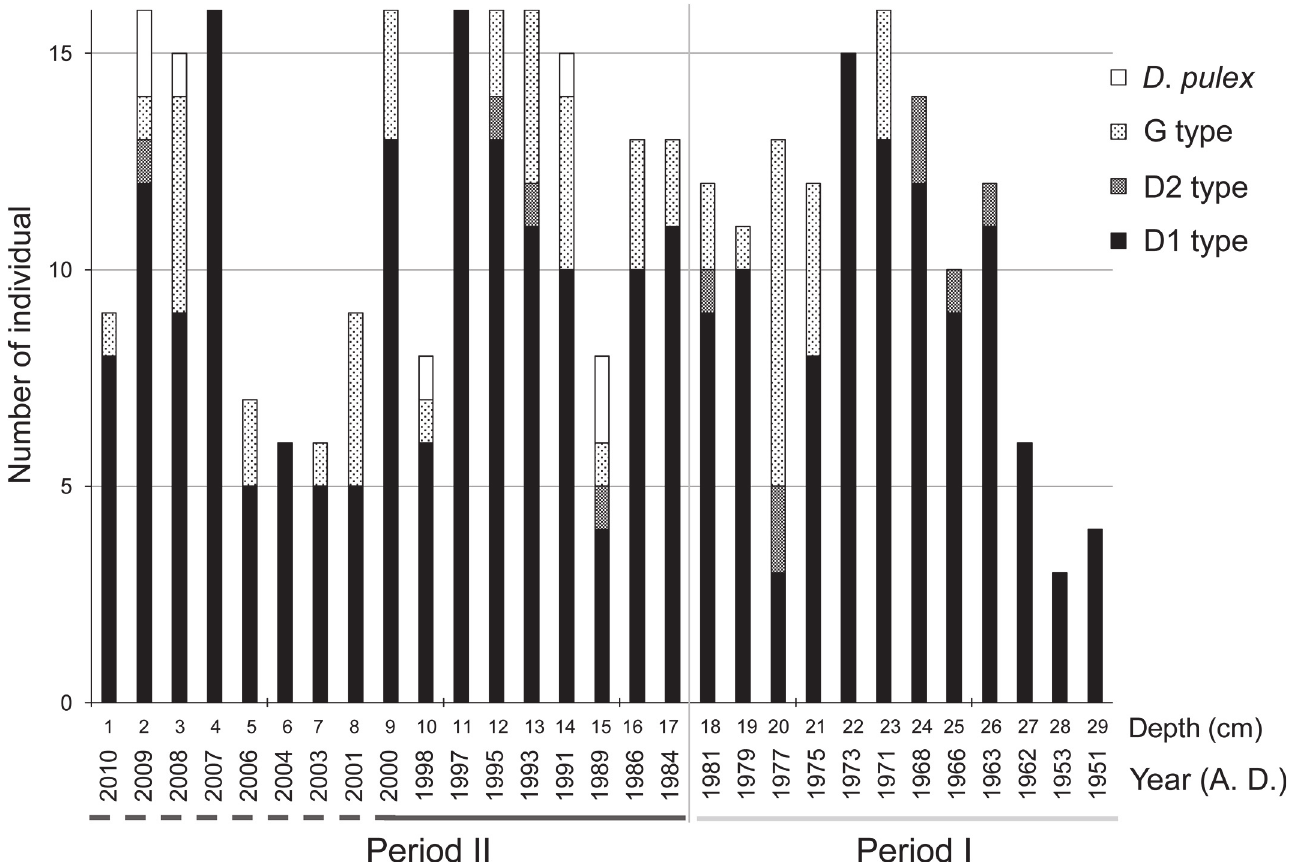
Fig 8. Number of ephippial carapaces with haplotypes D1, D2, G and D . pulex in different chronological layers. Total of 334 ECs were successfully analyzed. Two distinctly divided periods are denoted by a gray line (period I) and dark gray line (period II). Inaccurately estimated chronological years are shown with a broken